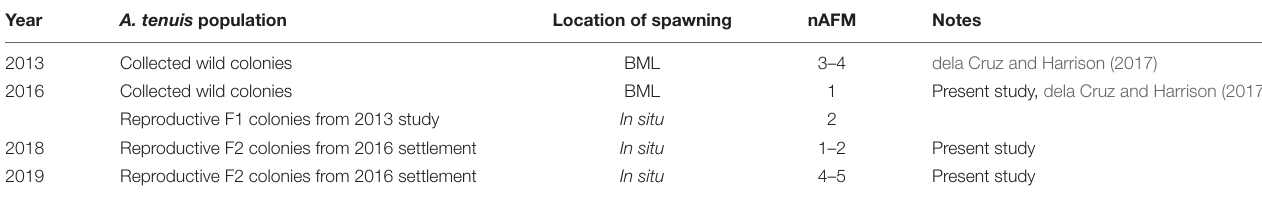
TABLE 1 | Lunar periodicity of A. tenuis spawning in 2013 and 2016